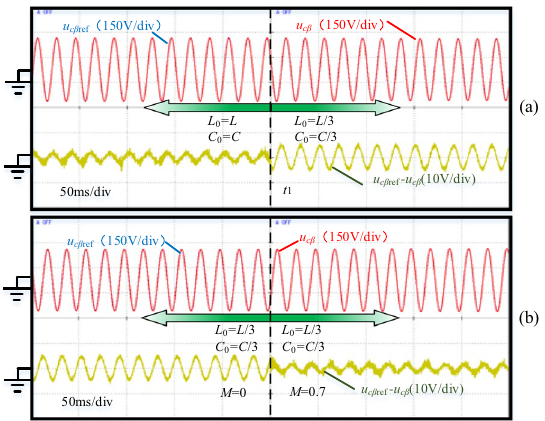
Fig. 13 a Experimental results during sudden change of parameters. b Comparison of the two strategies